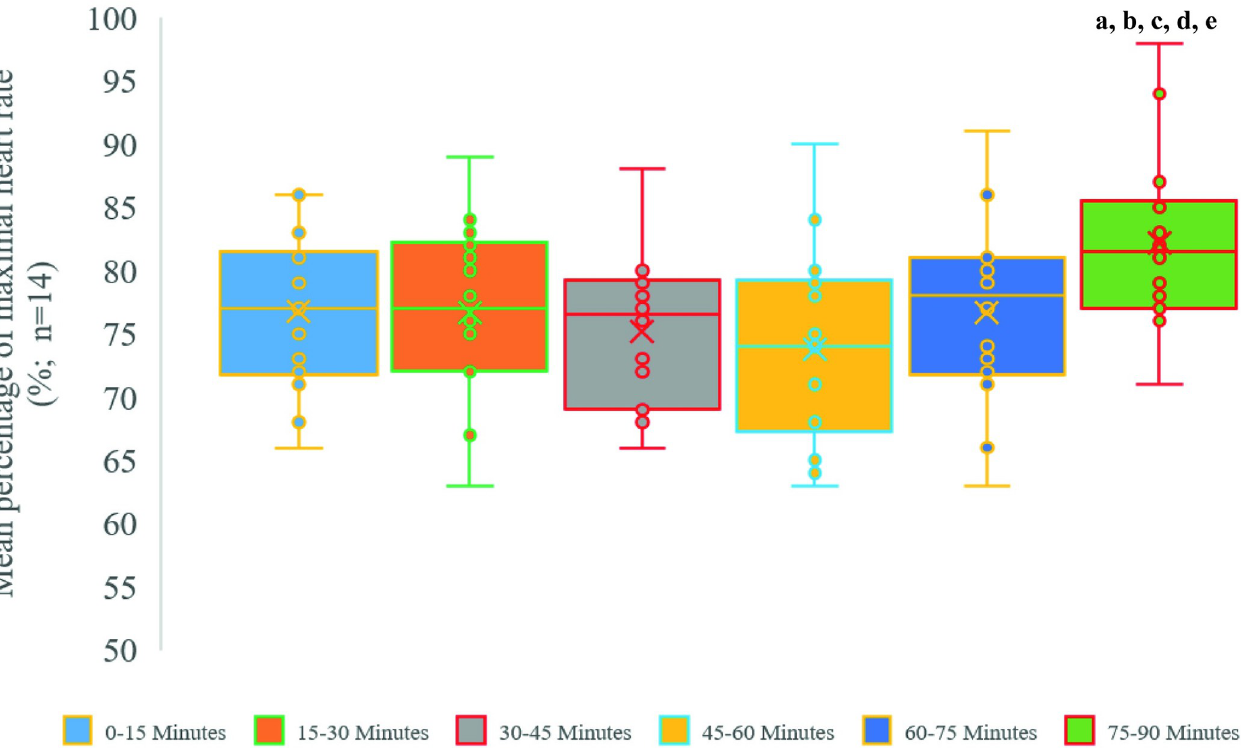
Fig 5. Box & Whisker plots show the mean percentage of maximal heart rate of each fifteen minutes across ninety minutes of the TSAFT 90 football simulation. The first box with blue colour represents the mean percentage of maximal heart rate of 0–15 minutes, the second box with the orange colour indicates the mean percentage of maximal heart rate of 15–30 minutes, the third box with grey colour refers to the mean percentage of maximal heart rate of the 30–45 minutes, the fourth box with yellow colour points out the mean percentage of maximal heart rate of the 45–60 minutes, the fifth box with navy blue colour demonstrates the mean percentage of maximal heart rate of the 60–75 minutes, and the sixth box with green colour shows the mean percentage of maximal heart rate of the 75–90 minutes of the TSAFT 90 football simulation. Abbreviations: a , significantly higher than 0–15 minutes (p = 0.021); b , significantly higher than 15–30 minutes (p = 0.014); c, significantly higher than 30–45 minutes (p < 0.001); d, significantly higher than 45–60 minutes (p = 0.001); e , significantly higher than 60–75 minutes (p = 0.013). Abbreviations: n, sample